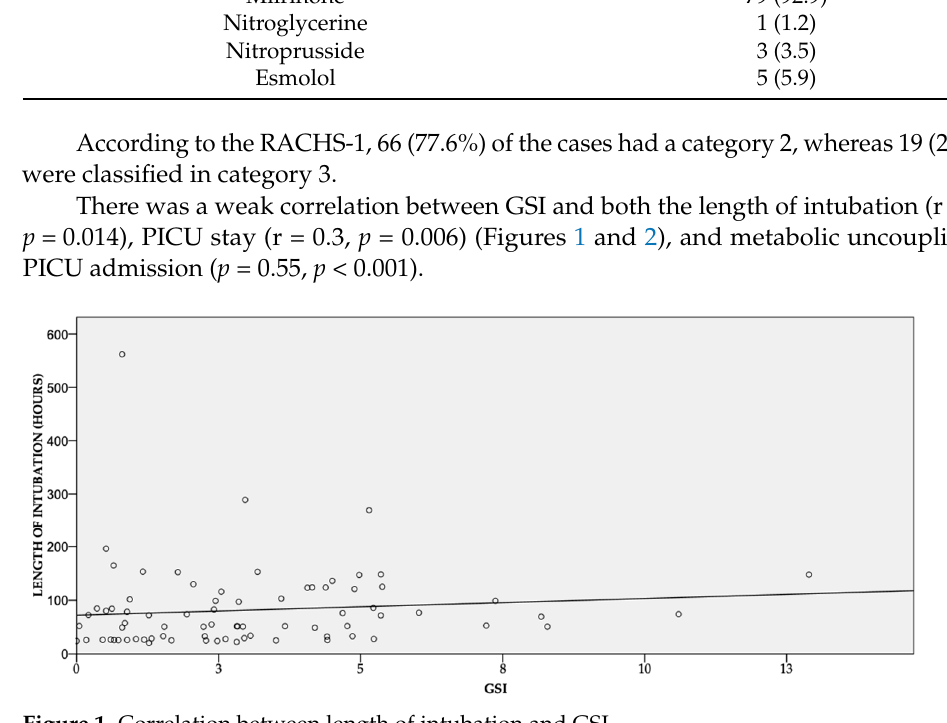
Figure 1. Correlation between length of intubation and GSI.